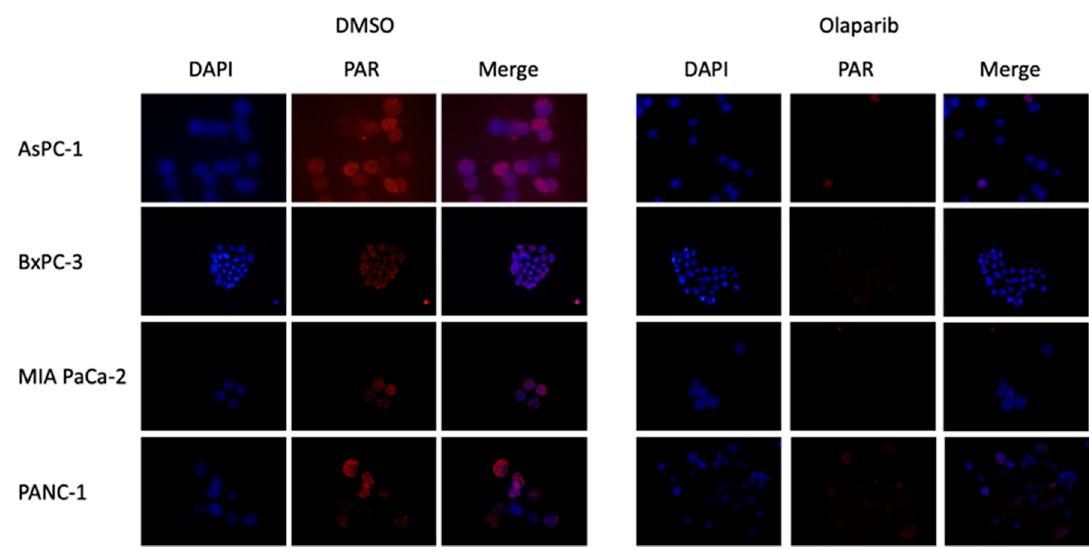
Figure 2. Immunodetection of poly ADP-ribose (PAR) in AsPC-1, BxPC-3, MIA PaCa-2 and PANC-1 cell lines either untreated (DMSO) or treated with olaparib (1 µM). DNA is counterstained with DAPI. Magnification 40x.